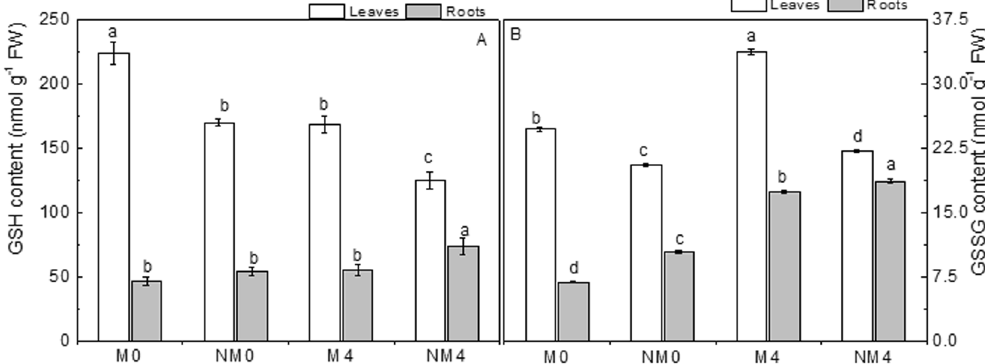
Figure 5. The concentrations of glutathione (GSH, μ mol g − 1 FW; A ) and oxidized glutathione (GSSG, nmol g − 1 FW; B ) in tender leaves and fine roots after 30 days of irrigation with magnetized and non-magnetized brackish water. The values are the means of three replicates ± SEs. Different lowercase letters show significant differences between means in the same row at the 0.05 probability